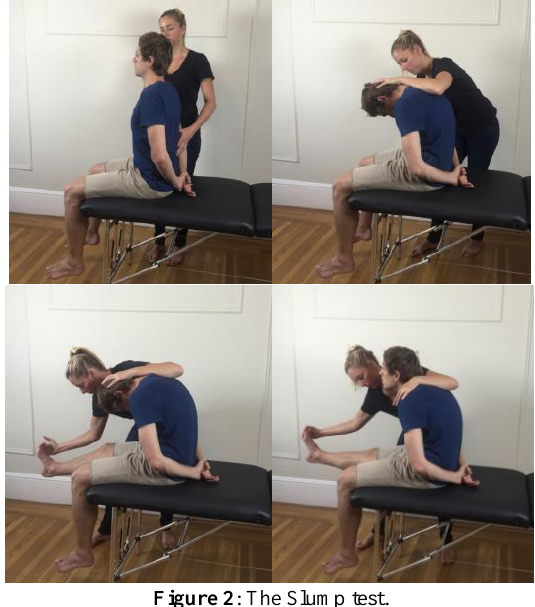
Figure 2 : The Slump